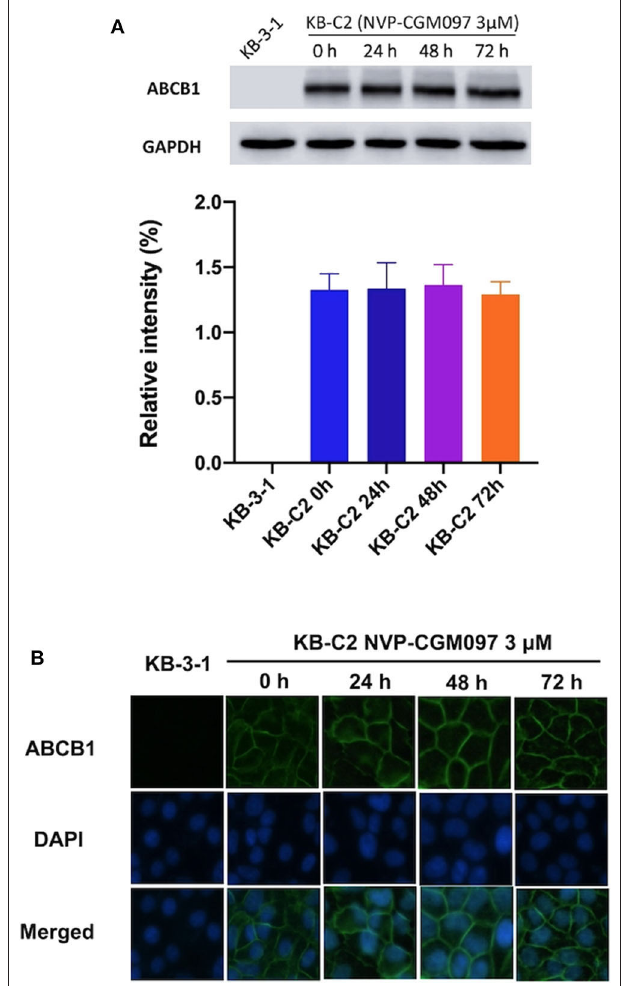
FIGURE 2 | The effect of NVP-CGM097 on the protein expression and subcellular localization of ABCB1 transporters. (A) Detection of ABCB1 expression in KB-C2 cells incubated with 3 µ M of NVP-CGM097 for 0, 24, 48, and 72h. (B) Sub-cellular localization of ABCB1 expression in KB-C2 cells incubated with 3 µ M of NVP-CGM097 for 0, 24, 48, and 72h. Data are mean ± SD, representative of three independent experiments. Green: ABCB1. Blue: DAPI counterstains the nuclei. KB-3-1 represented the control